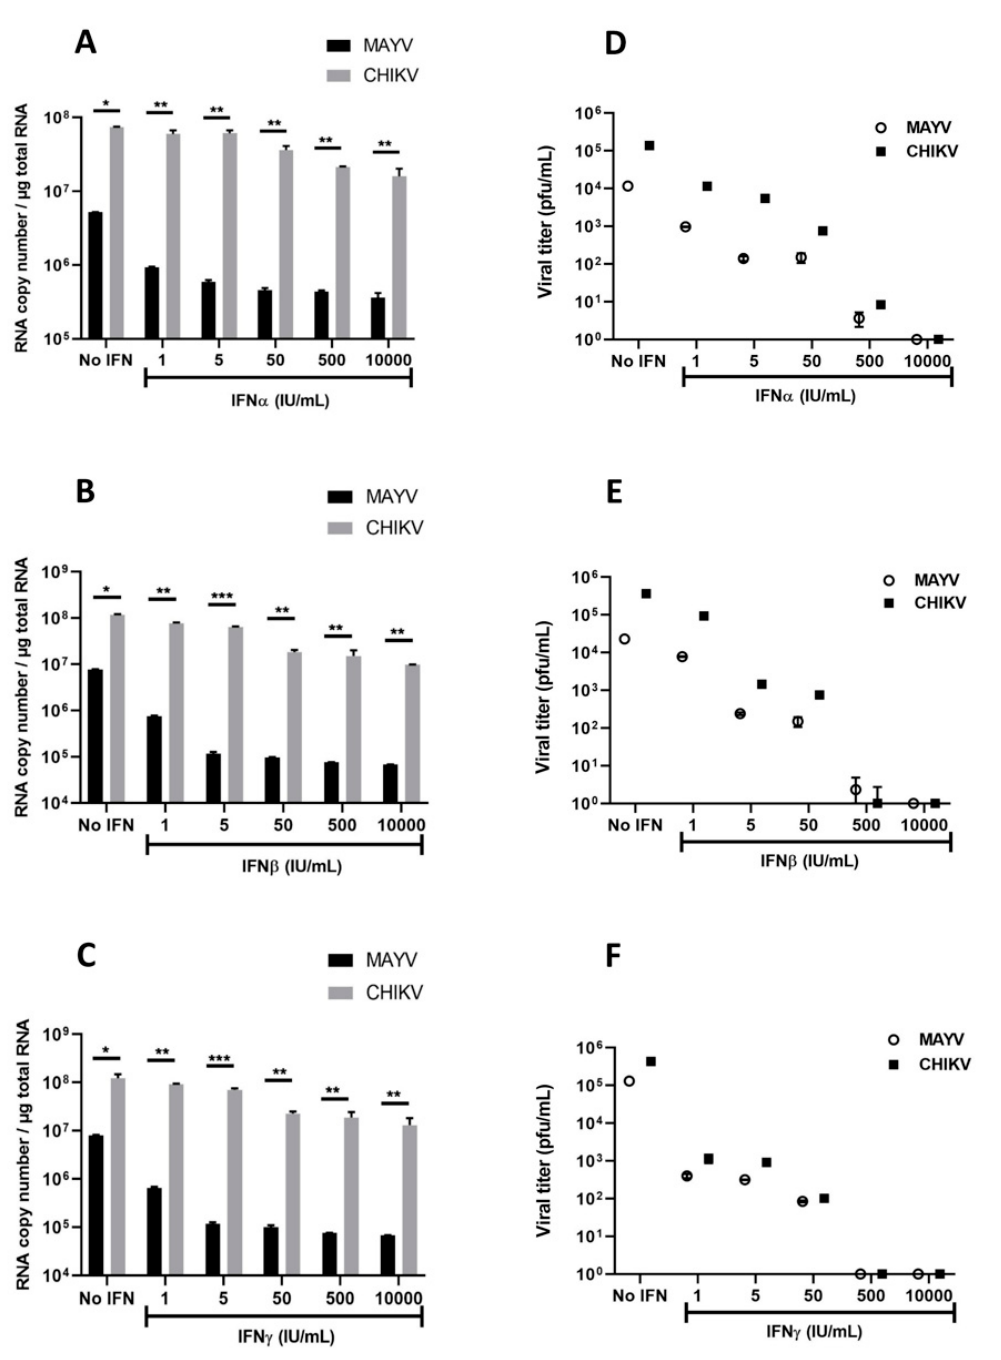
Figure 7. Interferons inhibit MAYV and CHIKV infection in primary human astrocytes. Cells, pre-treated in the absence or presence of various concentrations (1, 5, 50, 500, 10,000 IU/mL) of IFNs for 6 h, were infected with MAYV and CHIKV at MOI 1 for 48 h. Viral RNA was quantified by RT-qPCR ( A – C ), and infectious viral particles were measured using plaque assay ( D – F ). The experiments have been obtained from three independent experiments ( n = 3) each performed in duplicate, and statistical analysis was carried out by using a one-way ANOVA test. Asterisks represent the statistically significant differences between the data (* p < 0.05, ** p < 0.005, *** p < 0.001) from three independent experiments.